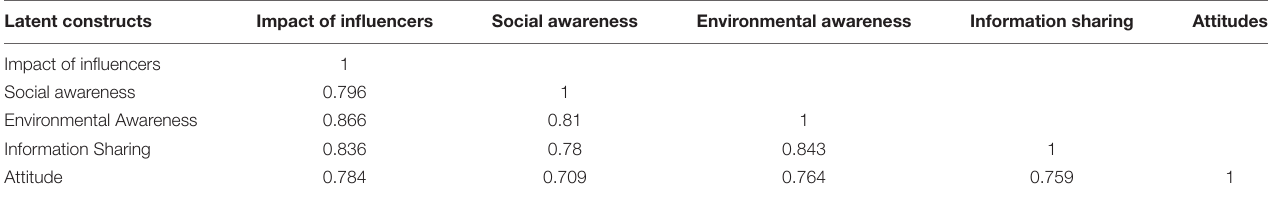
TABLE 3 | Correlations among latent